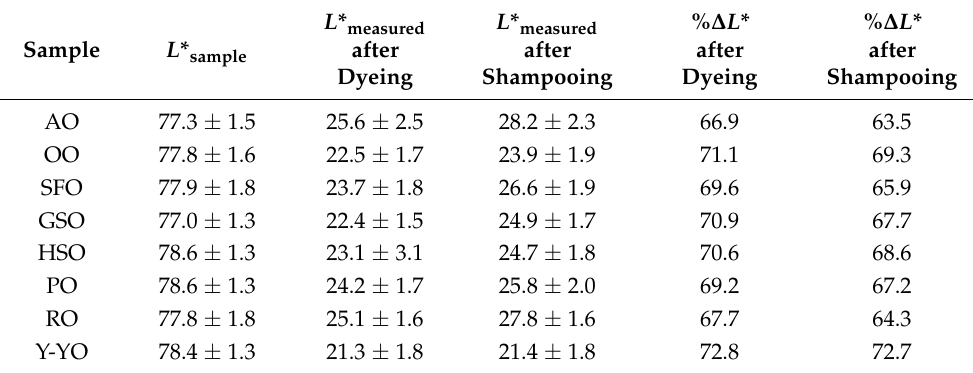
Table 1. Percent L * value change (% ∆ L *) after hair dyeing and shampooing. % ∆ L * = ( L * sample − L * measured )/ L * sample × 100. AO: argan oil; OO: olive oil; SFO: sunflower oil; GSO: grape seed